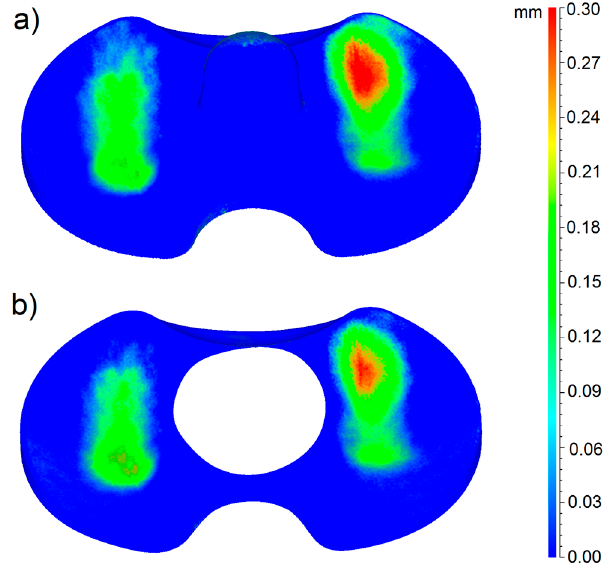
Figure 6. 3D wear map of the fixed meniscus #4: in part a , the 3D wear map of the entire prosthesis is shown; in part b , the 3D wear map of the butterfly region is shown.